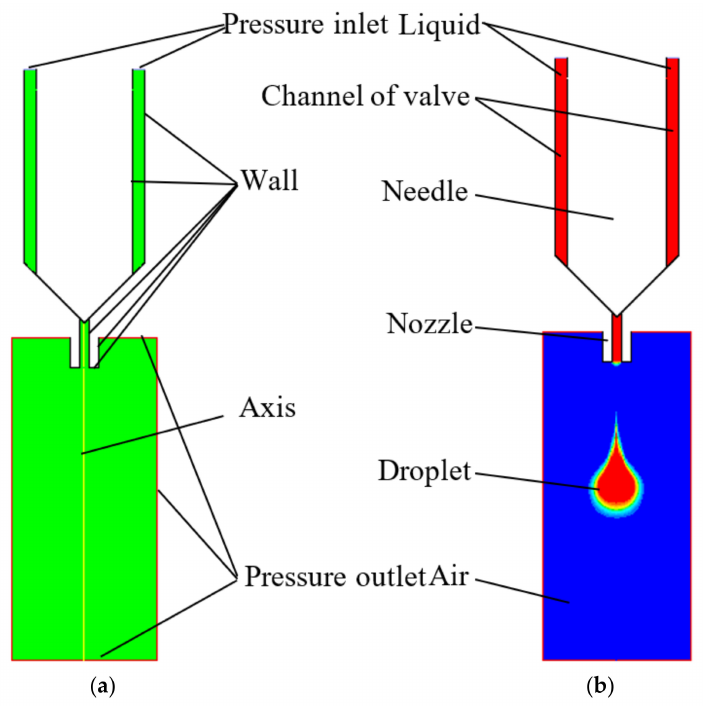
Figure 2. The simulation models: ( a ) gambit mesh model; ( b ) computational fluid dynamics (CFD) simulation